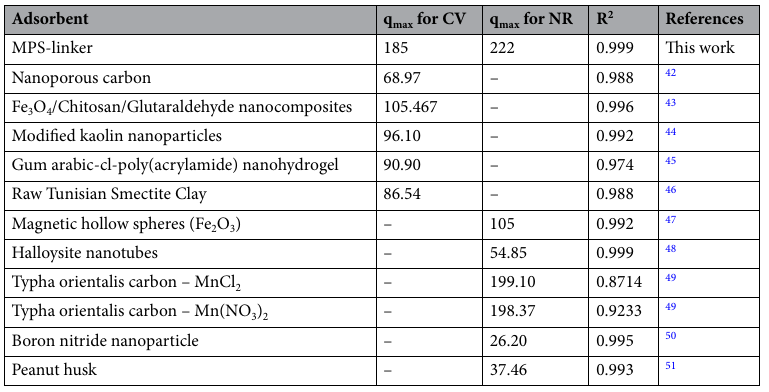
Table 1. Comparison of the capacity of adsorption for MPS-linker and other similar adsorbents (according to the Langmuir